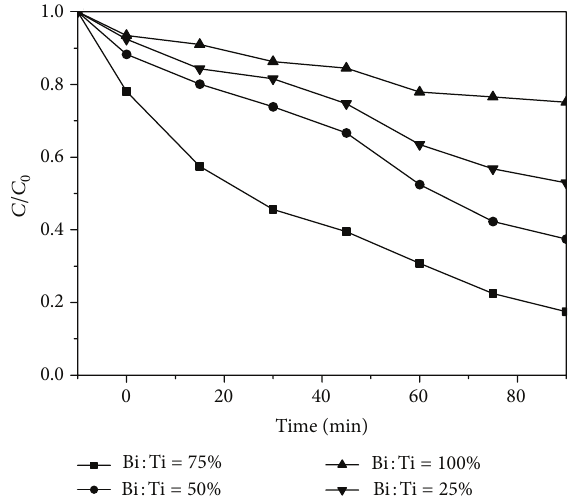
Figure 6: The effects of different ratio rate of BiOI to TiO 2 on the photocatalytic degradation of BPA. Catalyst dosage = 0.5 g/L, initial pH = 5.8, and BPA concentration = 20 mg/L.